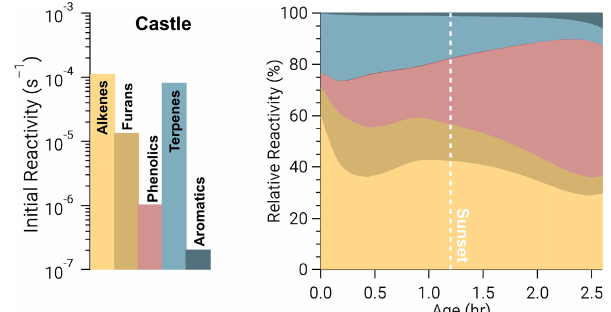
Figure 5. Ozone reactivity from the Castle model run in the form of absolute initial reactivity (bars, log scale) and relative BBVOC reactivity as a function of plume age (stacked, linear scale). As the plume ages, O 3 reactivity toward each BBVOC group changes sig-